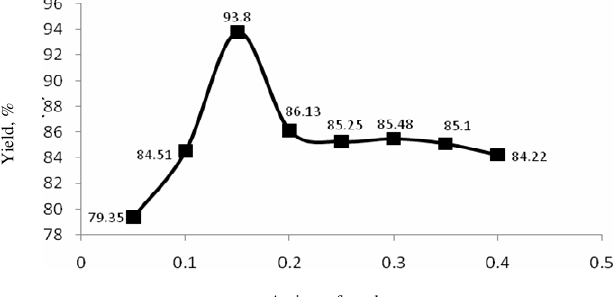
Figure 3. Effect of amount of catalyst on the esterification reaction of oleic acid and oleyl